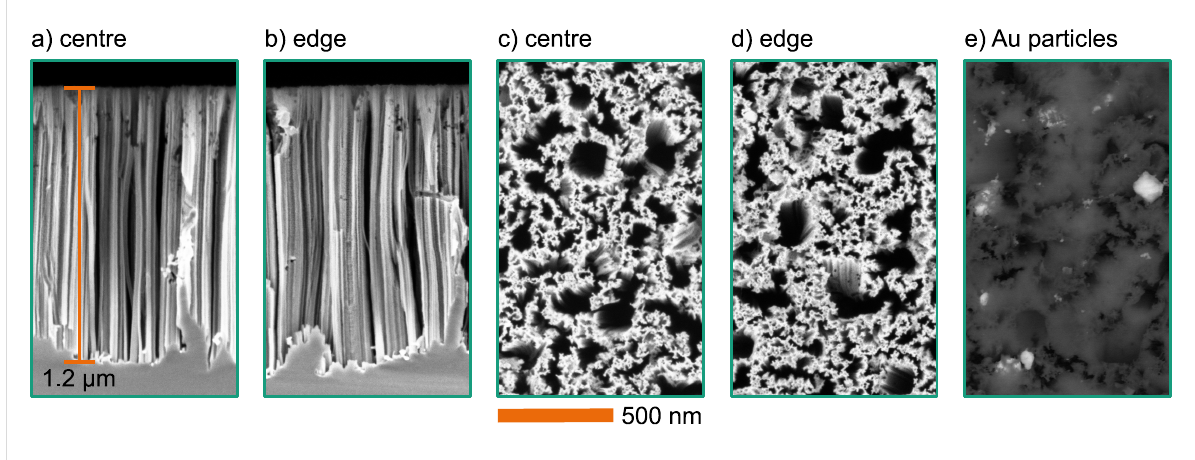
Figure 4: SEM images of etched structures (with 50 mmol/L H 2 O 2 and 1.73 mol/L HF for 10 min) using Au particles. (a, b): Cross section; (c, d): top view; (e): top view from back-scattering detector with highlighted Au particles. The scale applies to all images.